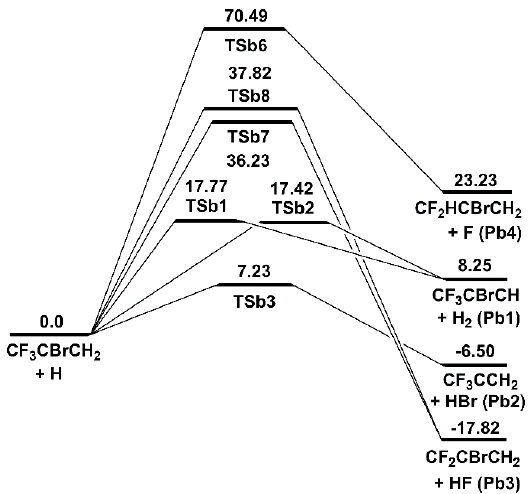
Figure 4. Schematic energy diagram of abstraction and substitution channels for the 2-BTP + H reaction at 0 K in kcal/mol at CCSD(T)/aug-cc-pVTZ//B3LYP/aug-cc-pVTZ (zero-point vibrational energy included).